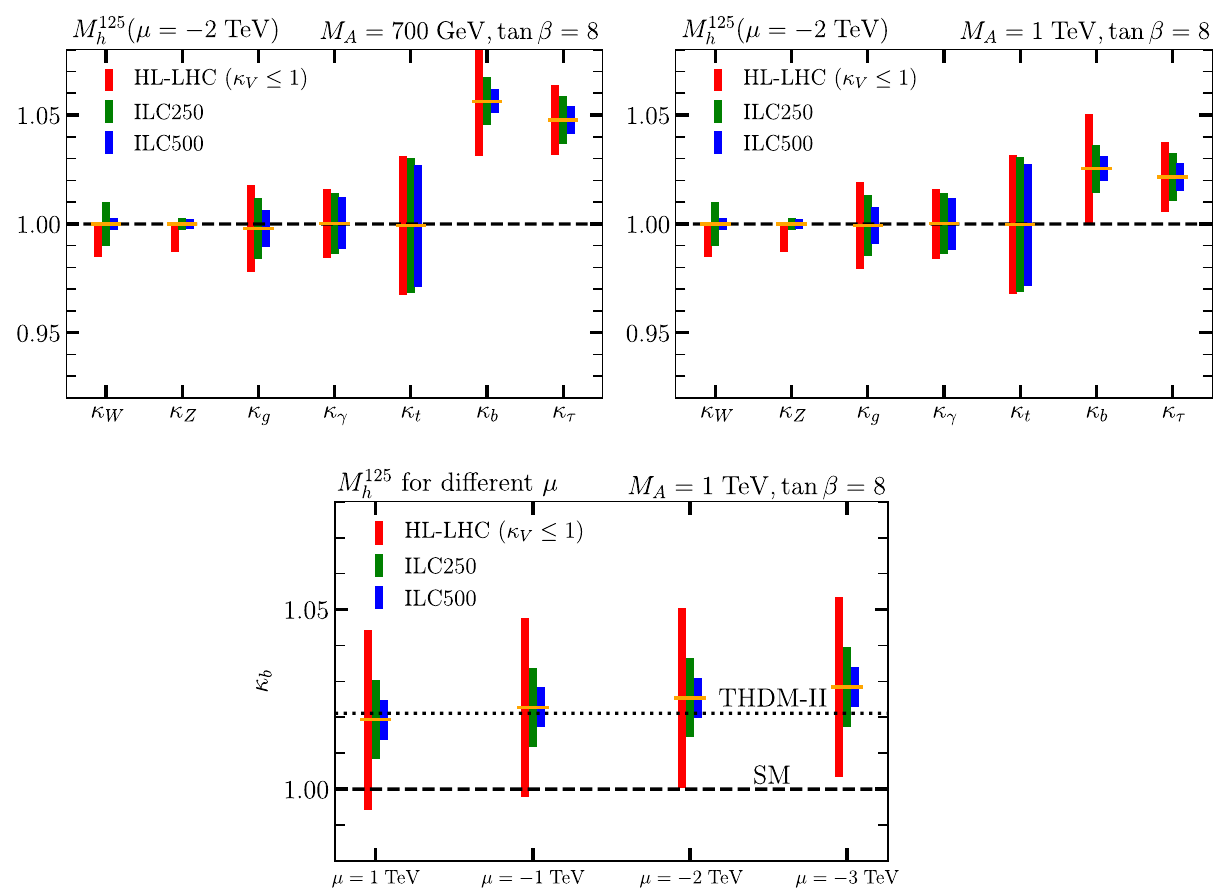
Fig. 11 Wäscheleinen-plots , using the same color coding as in tion in the THDM-II (see text) is indicated (dotted line), see text for Fig.9, for the two assumed MSSM parameter points ( M A , tan β) = details. The Higgs couplings in the κ framework predicted in the dis- ( 700GeV , 8 ) (upper left panel) and ( M , tan β) = ( 1TeV , 8 ) (upper played scenarios are compared with the anticipated 1 σ precision from A ,μ − Higgsratemeasurements,whereattheHL-LHCthetheoreticalassump- scenario. The lower panel shows for the right panel) in the M 125 h tion κ V ≤ 1 is employed, while for the results including prospective assumed point ( M A , tan β) = ( 1TeV , 8 ) and different values of μ the measurementsatILC250andILC500noassumptionon κ V isemployed prospects for κ b , where for comparison also the corresponding predic-